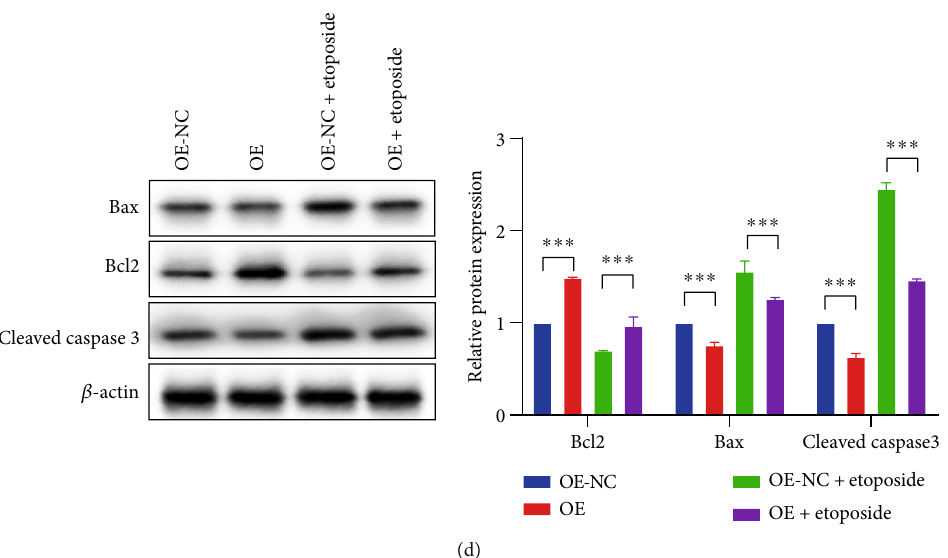
Figure 7: PTPRG overexpression activated oxidative phosphorylation and inhibited apoptosis. (a) The western blot bands of the PTPRG protein expression in OE-NC and OE groups (upper) and the statistical comparison bar plot of the results (lower). (b) The western blot bands showing the expression of the oxidative phosphorylation-related proteins (left) and their statistical comparison (right). (c) The scatter plots of the apoptosis analyzed by fl ow cytometry and their statistical comparison (right). (d) The western blot bands show the apoptosis-related protein expression di ff erences between OE-NC and OE groups treated with or without etoposide (left) and their statistical comparison